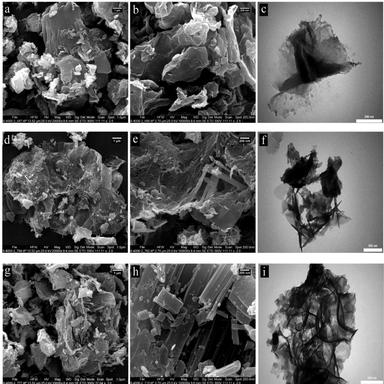
SEM images related to materials: a and b) GO, d and e) FGO-Bi(BDC), g and h) FGO-Bi(BTC). TEM images of materials: c) GO, f) FGO-Bi(BDC), and i) FGO-Bi(BTC).